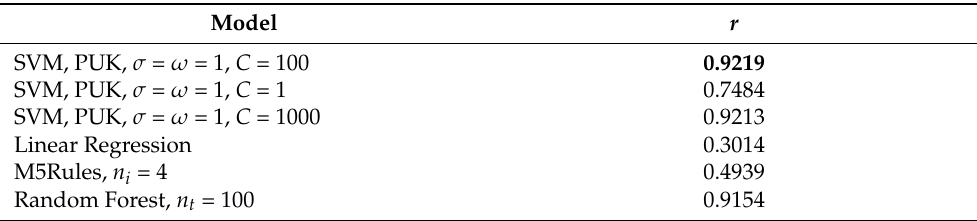
Table 5. Cross-validation results for color removal/discoloration (with pH influence).